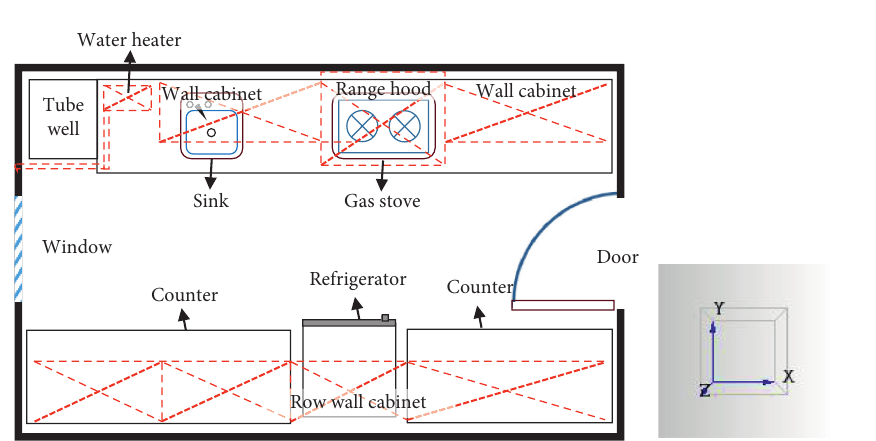
Figure 2: Layout of the type II